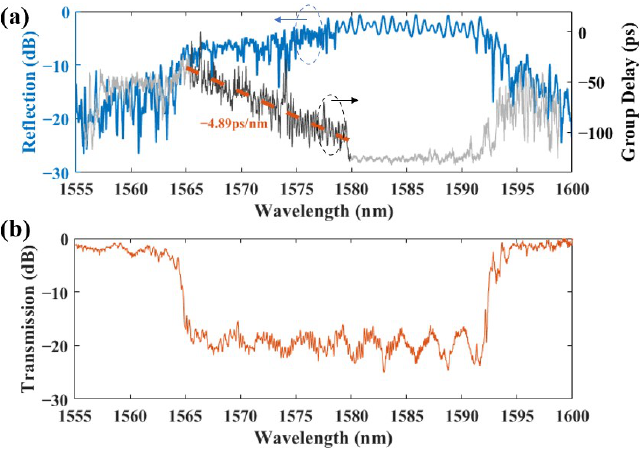
Figure 6. ( a ) Measured reflection spectrum from the drop port and the corresponding group delay. ( b ) Measured transmission spectrum from the through port.